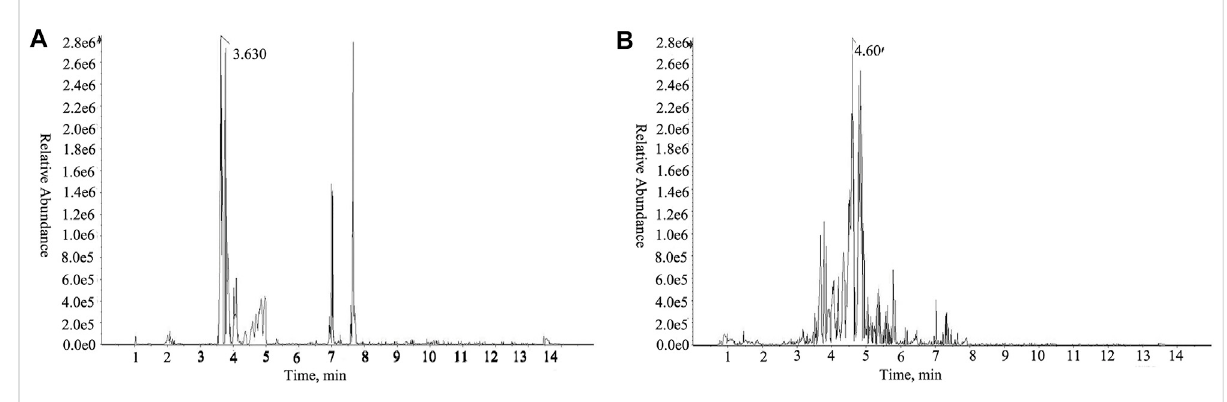
FIGURE 2 TIC detection diagram in the positive ion mode of UHPLC-Q-TOF-MS of HLJDD. (A) Mixed standard; (B)